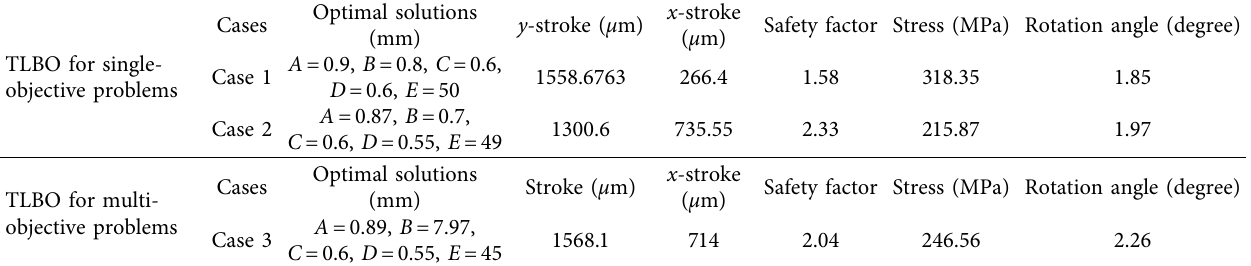
Table 8: Optimum results for three case studies.